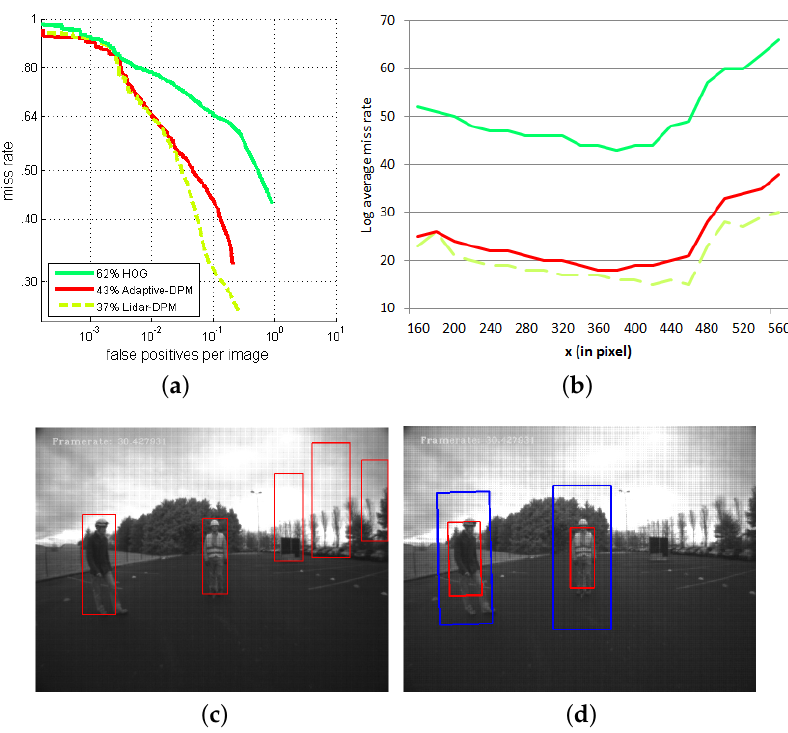
Figure 17. Comparison of detection performance between the exclusively vision-based approaches and the LiDAR-fisheye camera PDS in Configuration 1: ( a ) ROC curve, ( b ) miss rate for lateral image position, ( c ) vision-only detections and ( d ) LiDAR-fisheye